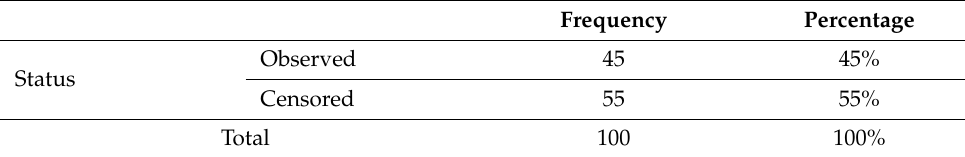
Table 2. Willingness of respondent farmers to pay RFIP premium.